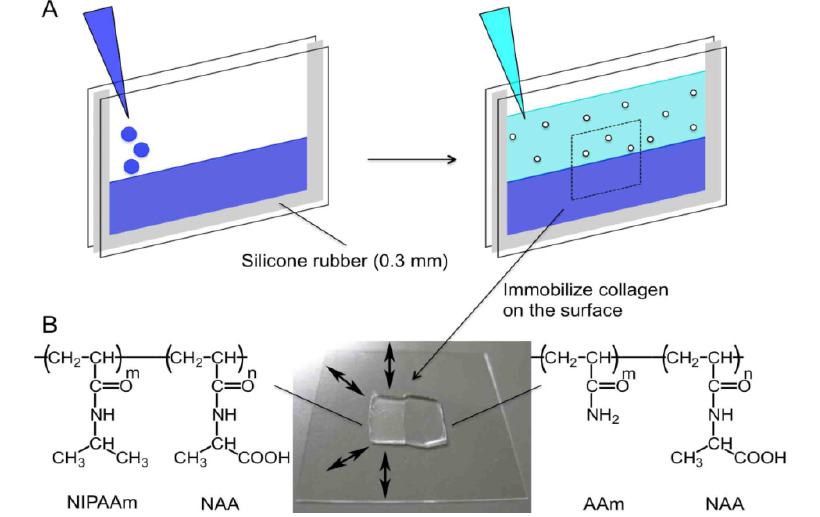
Figure 1. ( A ) Scheme for preparation of poly( N -isopropylacrylamide) (PNIPAAm)/polyacrylamide (PAAm) combined hydrogel. First, an aqueous solution of PAAm was poured between two glass plates, separated by a silicone rubber spacer. After polymerization of PAAm, an aqueous solution of PNIPAAm was poured onto PAAm and polymerized. The gels were then cut to a suitable size, and collagen was immobilized on the hydrogel surface; ( B ) Representative picture of the combined gel. To discriminate between the two gels, microbeads were added to either of the gels. The picture represents microbeads embedded within the collagen immobilized PNIPAAm gel (left). Only the left side of the PNIPAAm gel was able to swell and deform as indicated by the arrows.